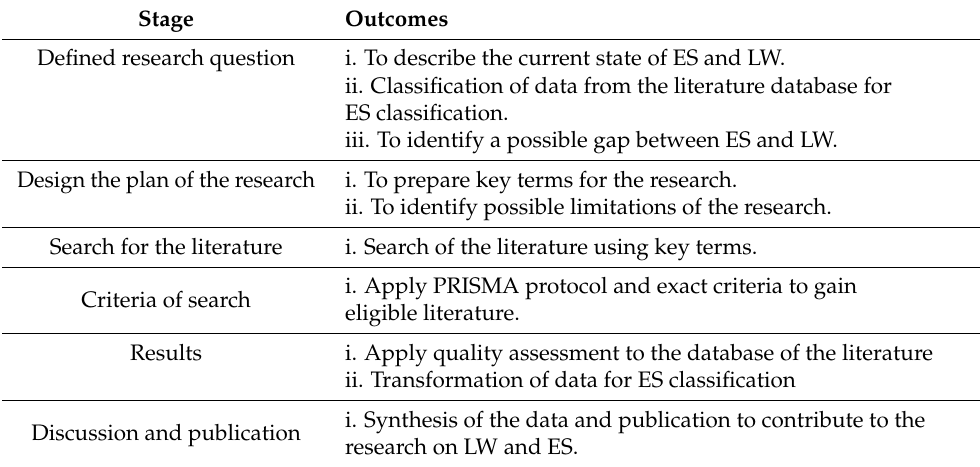
Table 1. The six stages of the systematic literature review (adapted from